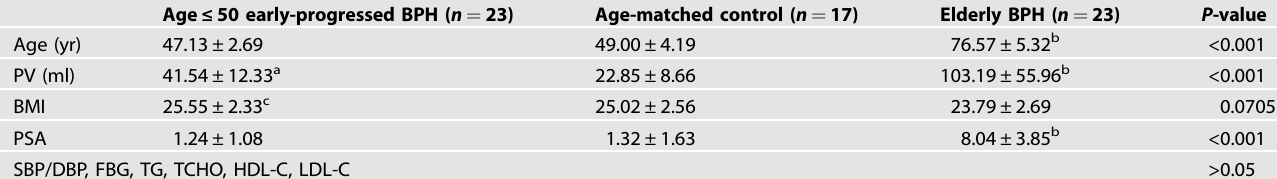
Table 1. Clinical characteristics of the three